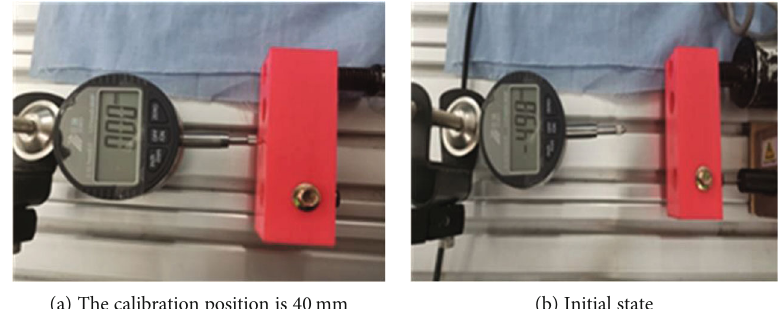
Figure 14: Calibration of hydraulic drive system.